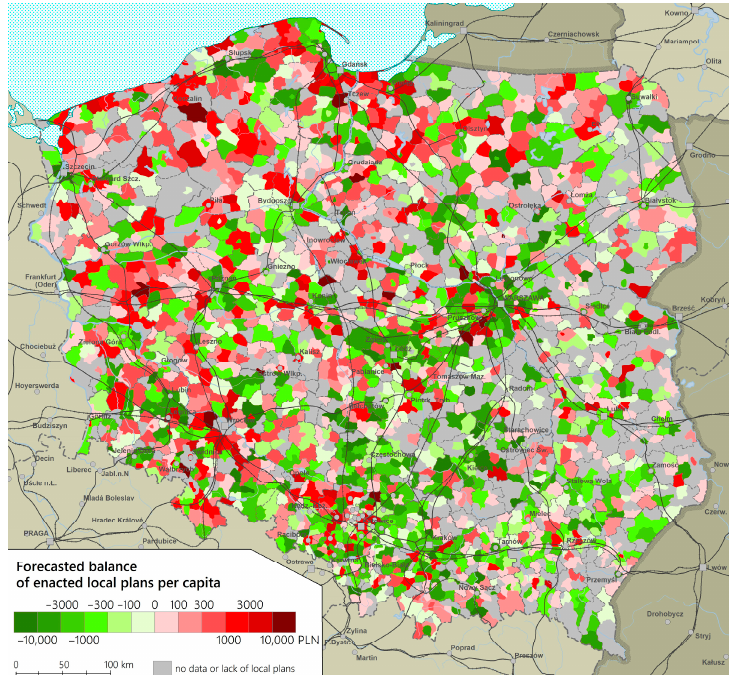
Figure 3. Forecast balance of revenues and expenditures per capita by communes, for the year 2019. Source: based on unpublished data of the Ministry of Development and Statistical Office of Poland.